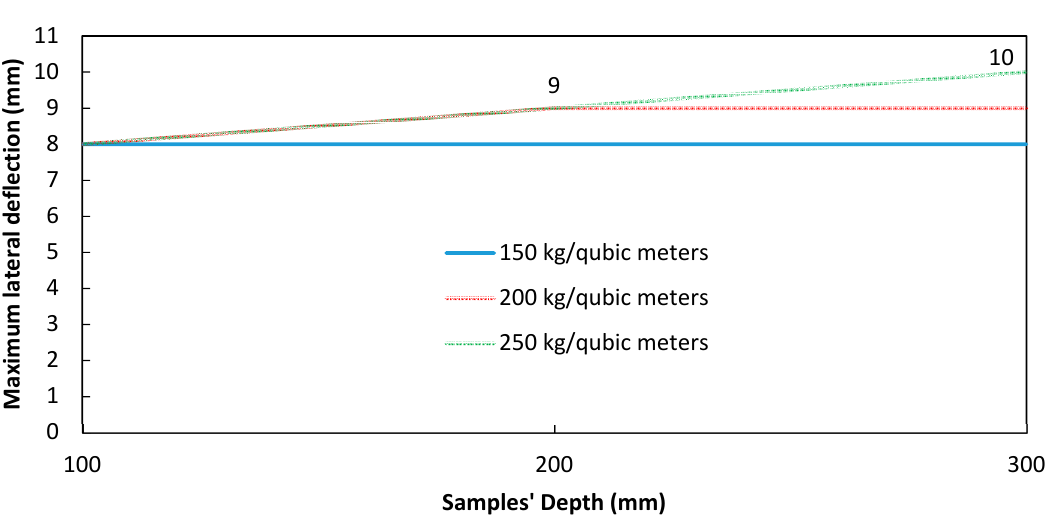
Figure 4. Effects of samples’ thickness and foam density on the maximum lateral deflection.